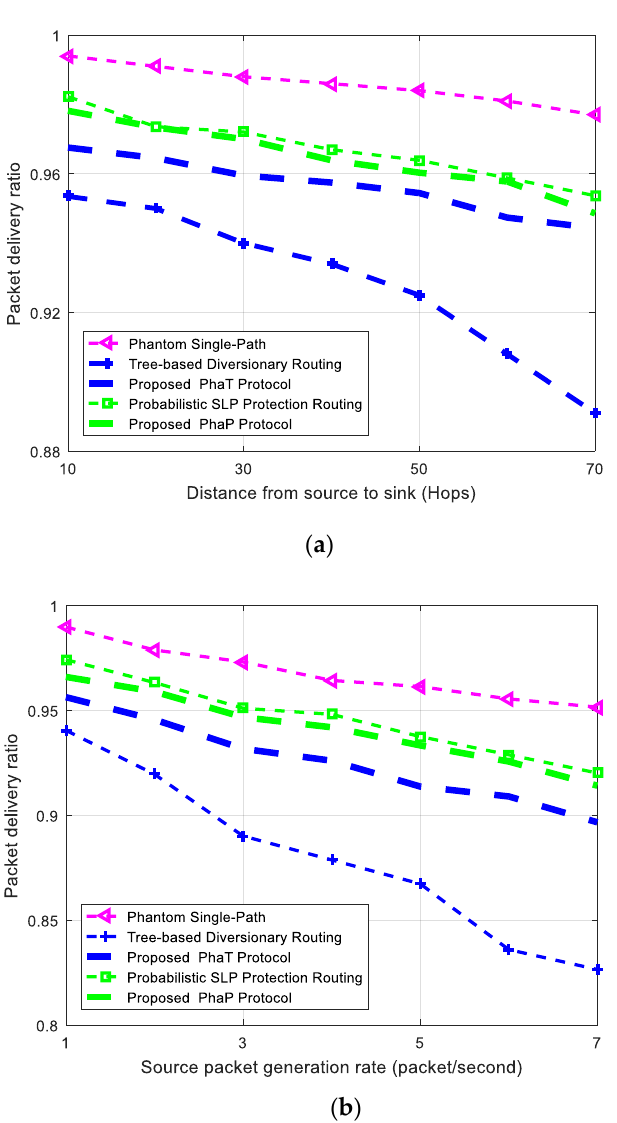
Figure 8. Packet delivery ratio (PDR) of the protocols. ( a ) PDR against varied source – sink distance. ( b ) PDR against varied source packet rate.